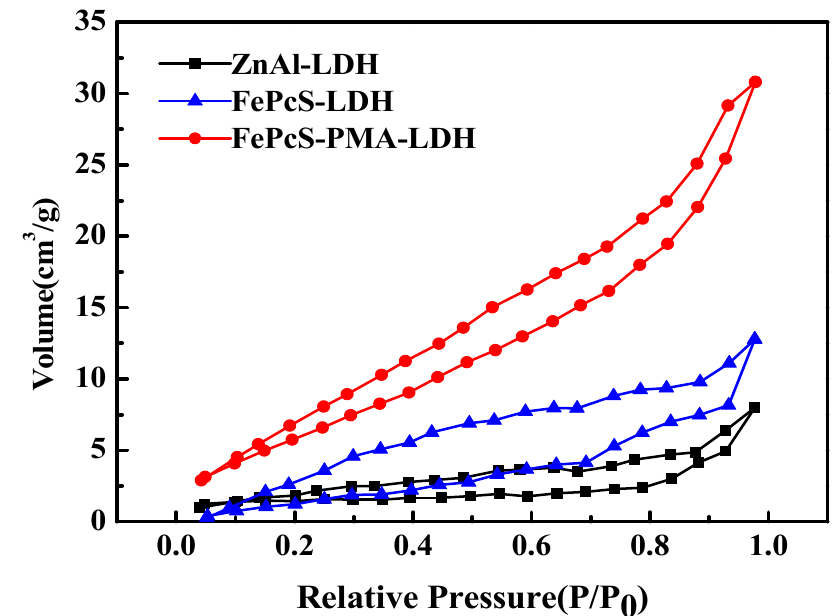
Figure 5. Nitrogen adsorption–desorption isotherms of ZnAl–LDH, FePcS–LDH, and FePcS–PMA–LDH.